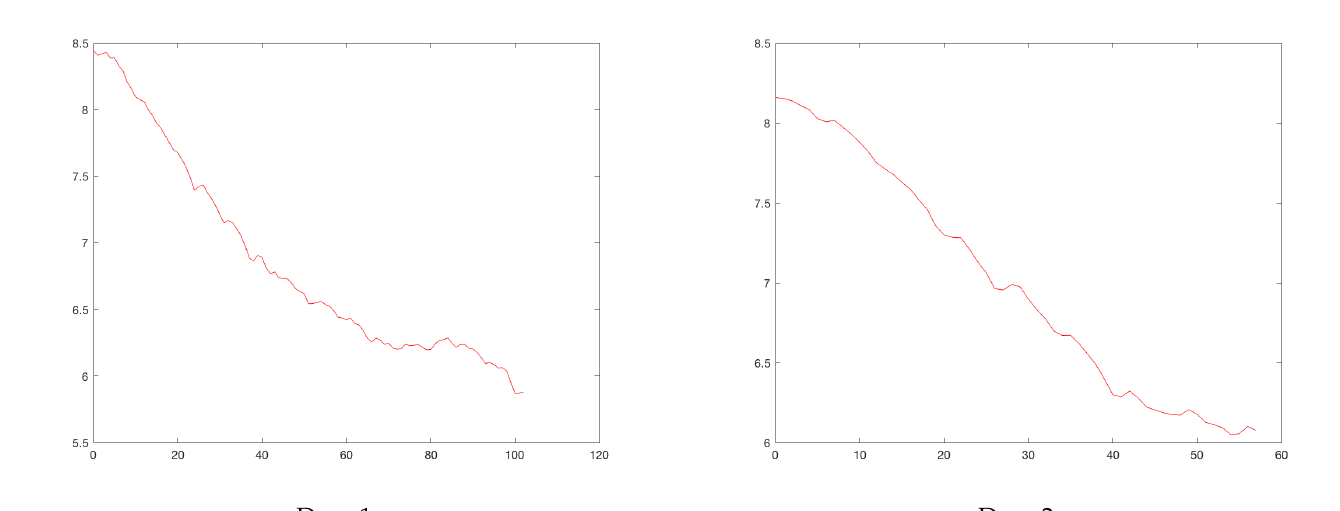
Drop 1 Drop 2 Figure A28. Chile Metropolitan Region’s drops. Horizontal axis, days; vertical axis: logarithm of daily cases.